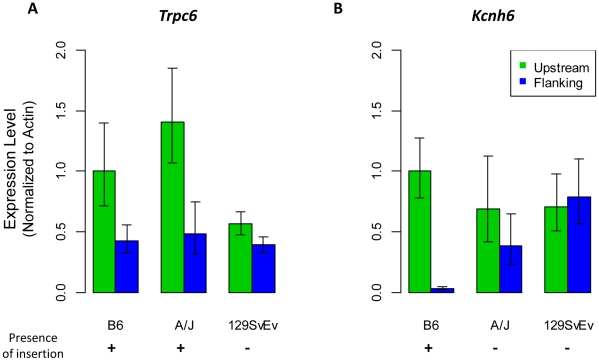
Effect of polymorphic LTR element insertions on transcription of the Trpc6 and Kcnh6 genes.Quantitative RT-PCR of the Trpc6 (A) and Kcnh6 (B) genes using brain RNA from the indicated mouse strains. Green bars show the amount of transcripts detected by the primer set upstream the polymorphic IAP insertion, and blue bars show the amount of transcripts detected by the primer set flanking the location of the IAP insertion. Each bar represents the mean of at least 4 experiments ± standard deviation, which was first normalized to β-actin levels in the queried strain, and then represented relative to 5′ expression levels for each gene in B6 mice. The plus/minus sign shows the presence/absence of the IAP insertion in the corresponding mouse strain, respectively.